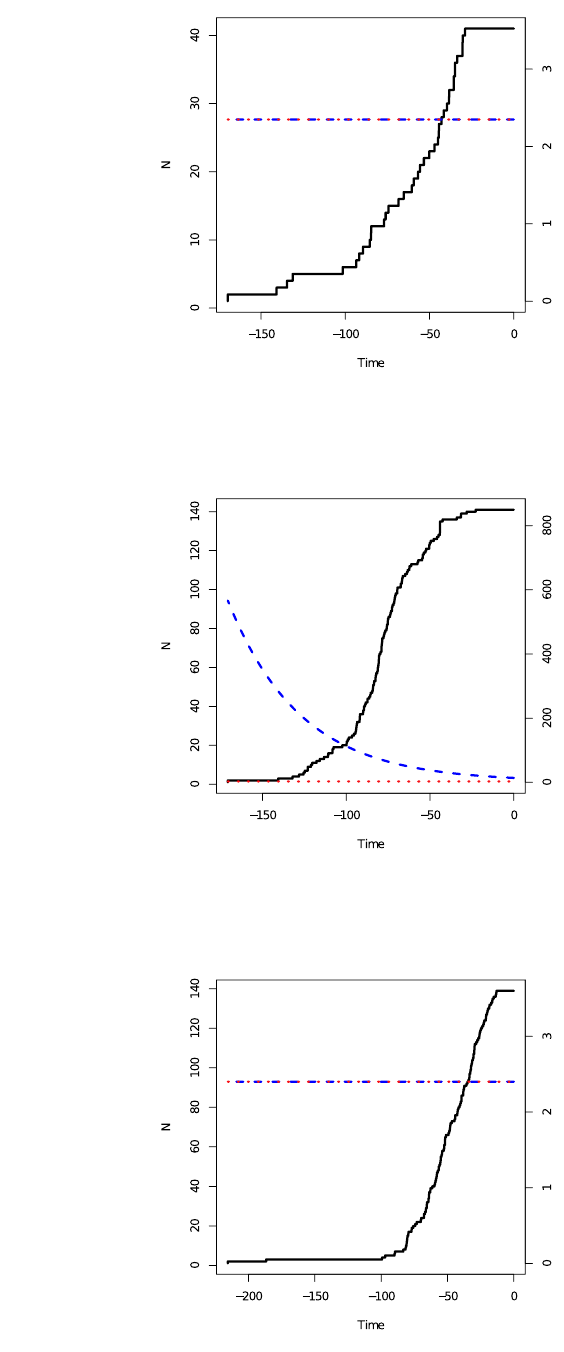
Figure 7. The estimated diversification rates for the snake, ant and mammal dataset. The plots show the change over time in total number of surviving lineages (solid black line), the speciation rate (dashed blue line) and the extinction rate (dotted red line) is given.